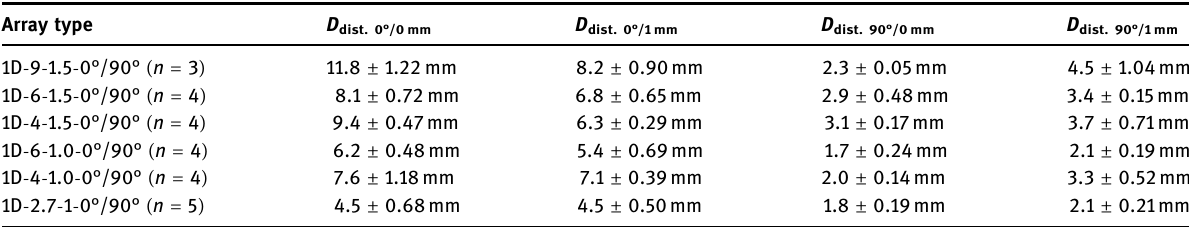
Table 3: Summary of average disturbed zones in 0° and 90° Array